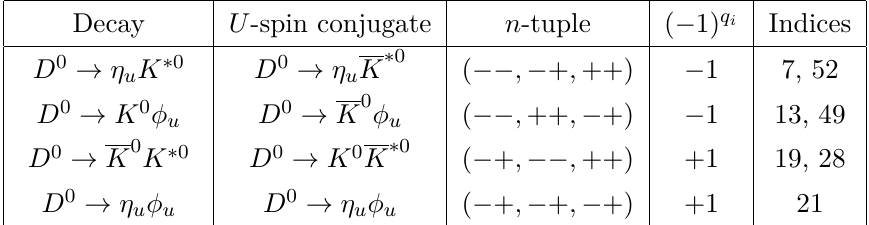
φ . The Hamiltonian and CKM factors for D → P 0 P ∗ 0 are the same as for D 0 → P + P − and C → L P − P + decays and are summarized in eqs. b b